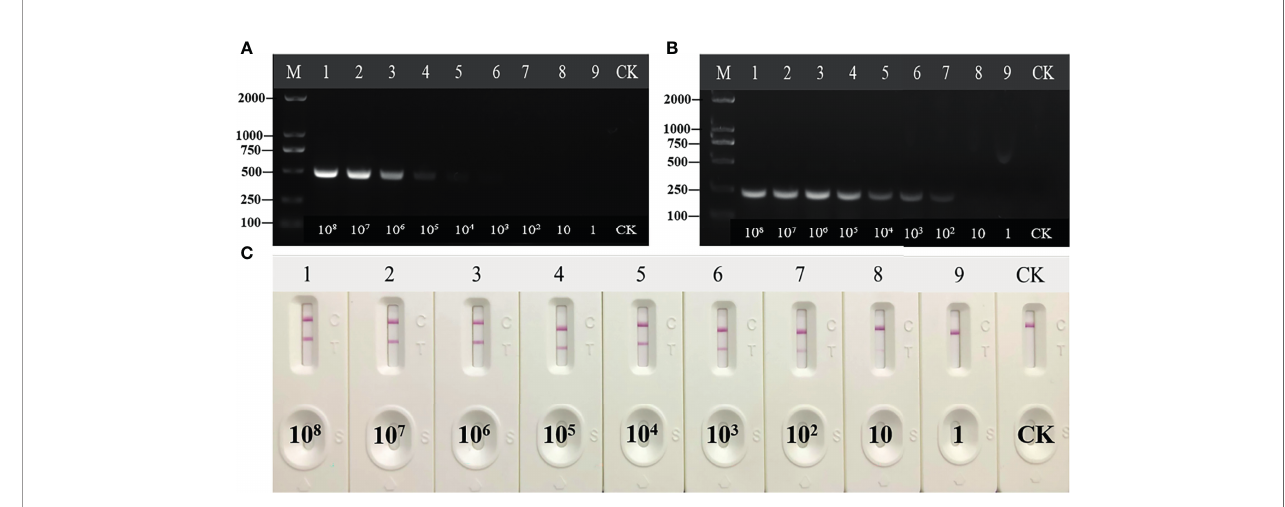
FIGURE 4 | Sensitivity of reverse transcription recombinase-aided ampli fi cation (RT-RAA), RT-RAA-lateral fl ow dipstick, and PCR for plasmid pUC57-pC/E1. (A) Agarose gel electrophoresis of PCR. M, DL2000DNA marker; 1 to 9, decimal dilutions of plasmid pUC57-pC/E1 from 10 8 copies/ml to 1 copy/ml. (B) Agarose gel electrophoresis of basic RAA. (C) RAA-LFA visual readout. CK, negative control with double-distilled water.